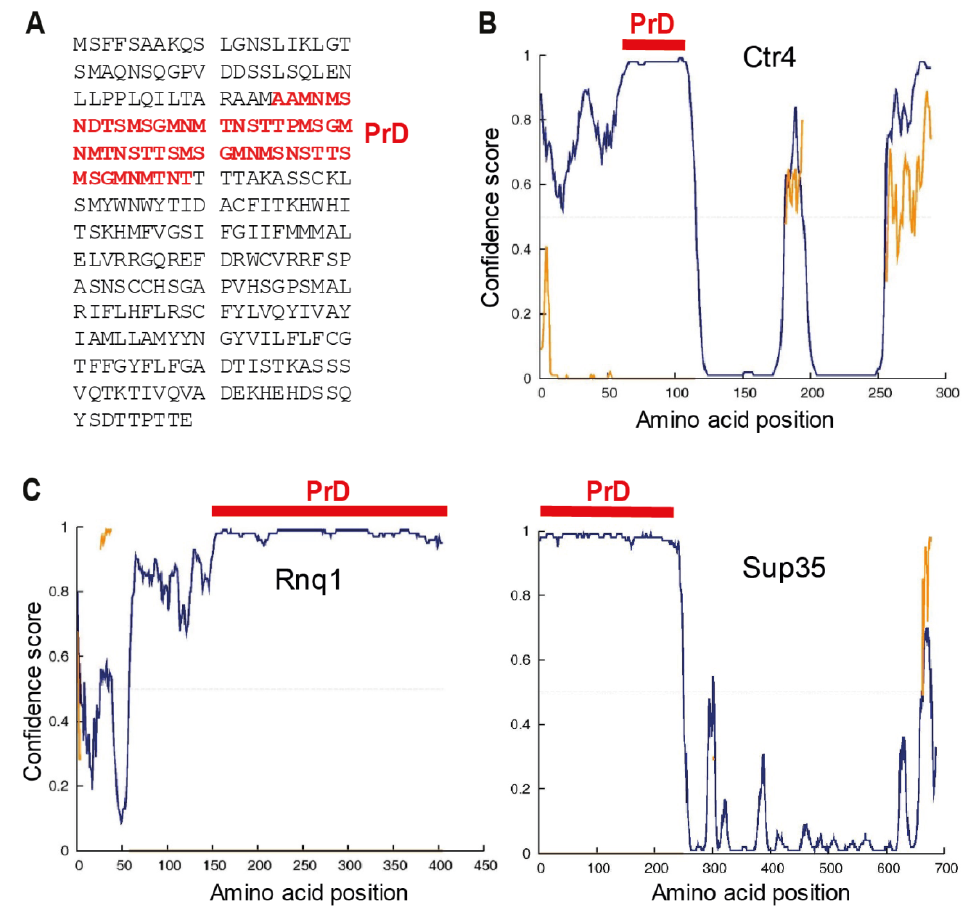
FIGURE 2: Sequence features of Ctr4 (A) The 289 amino acid Ctr4 protein contains a 55 amino acid prion-forming domain (PrD, red) as pre- dicted by the PLAAC algorithm [49]. (B) The predicted PrD of Ctr4 (red bar) coincides with the highest predicted unfolded region (disor- dered, blue curve) according to the DISOPRED3 algorithm [51]. The yellow trace is the location of predicted protein binding sites within disordered regions. (C) DISOPRED3 predictions of intrinsically disordered regions in two prion-forming proteins of S. cerevisiae , Rnq1 (left) and Sup35 (right), together with the locations of the experimentally defined PrDs, as in